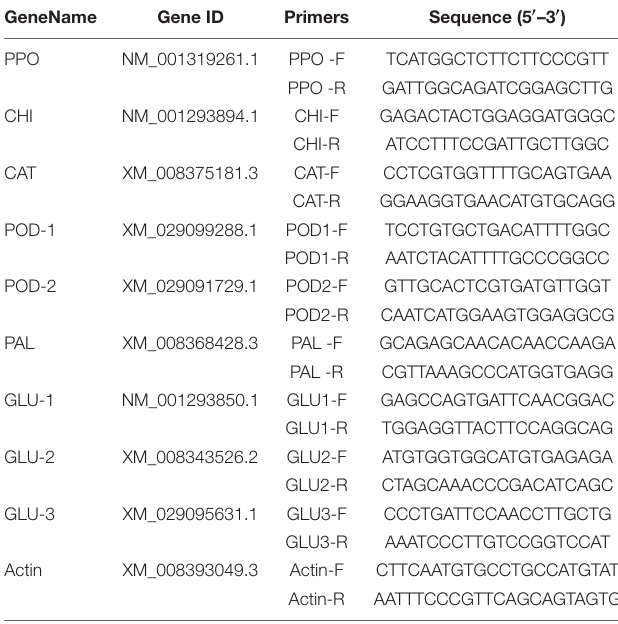
TABLE 1 | The primer sequences of defense-related genes and internal reference genes.